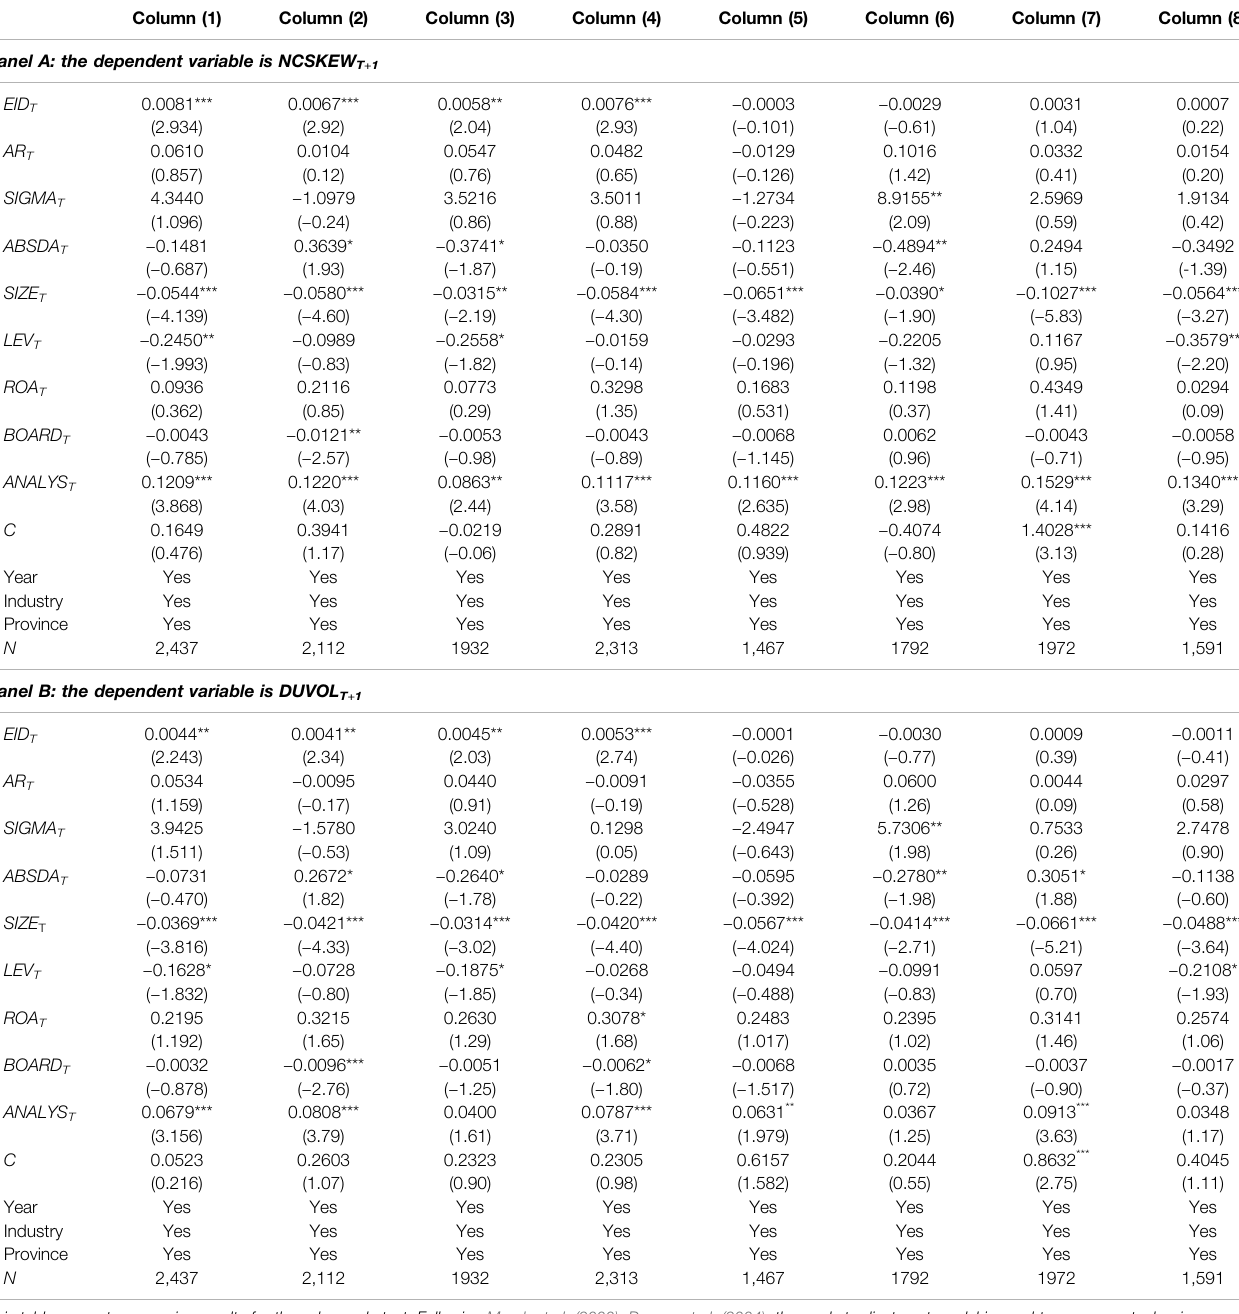
TABLE 4 | Subsample test of information ef fi